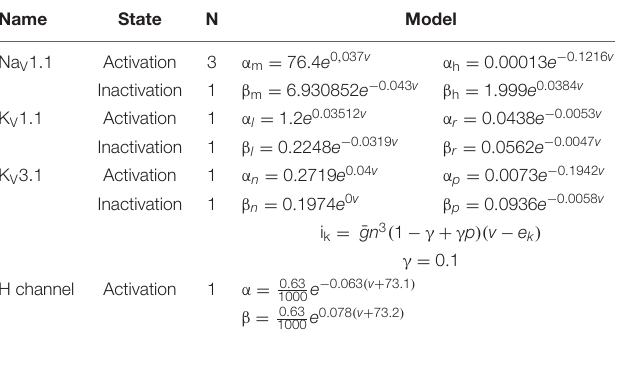
TABLE 2 | Kinetics of active